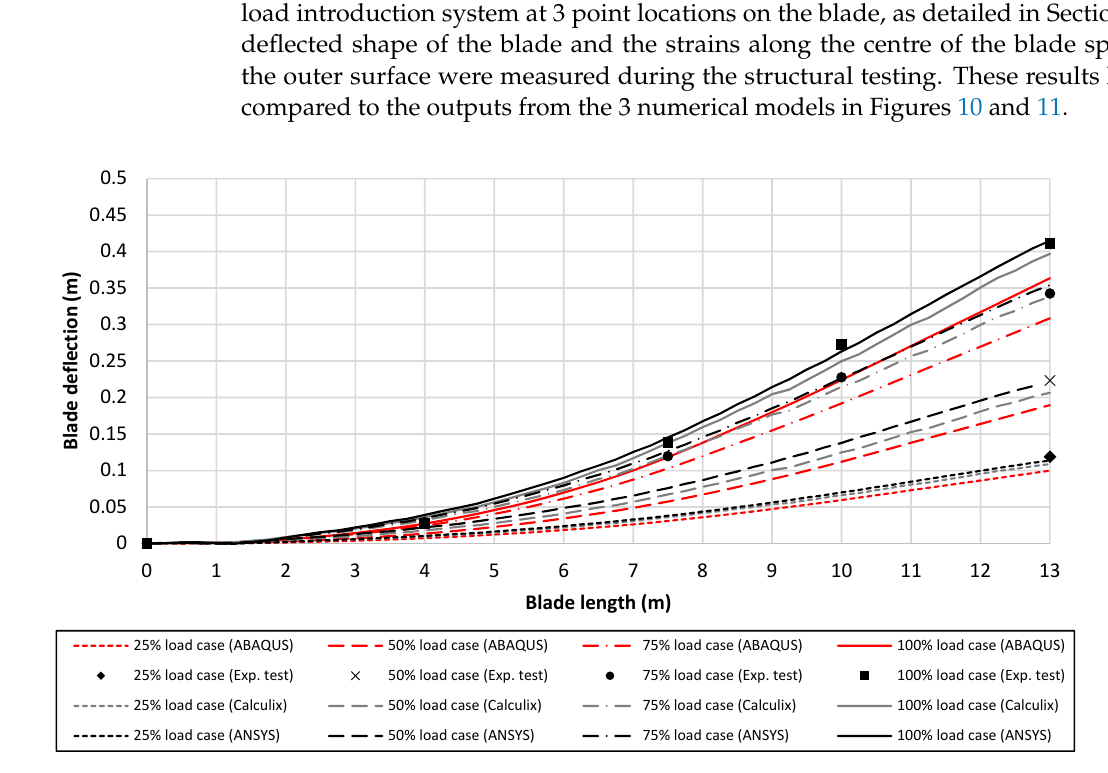
Figure 10. Comparison between the results from the 3 numerical models (ABAQUS, ANSYS, and CalculiX) and the results from the experimental static test showing the deflection along the blade (in m) for each of the load cases in the flapwise direction.